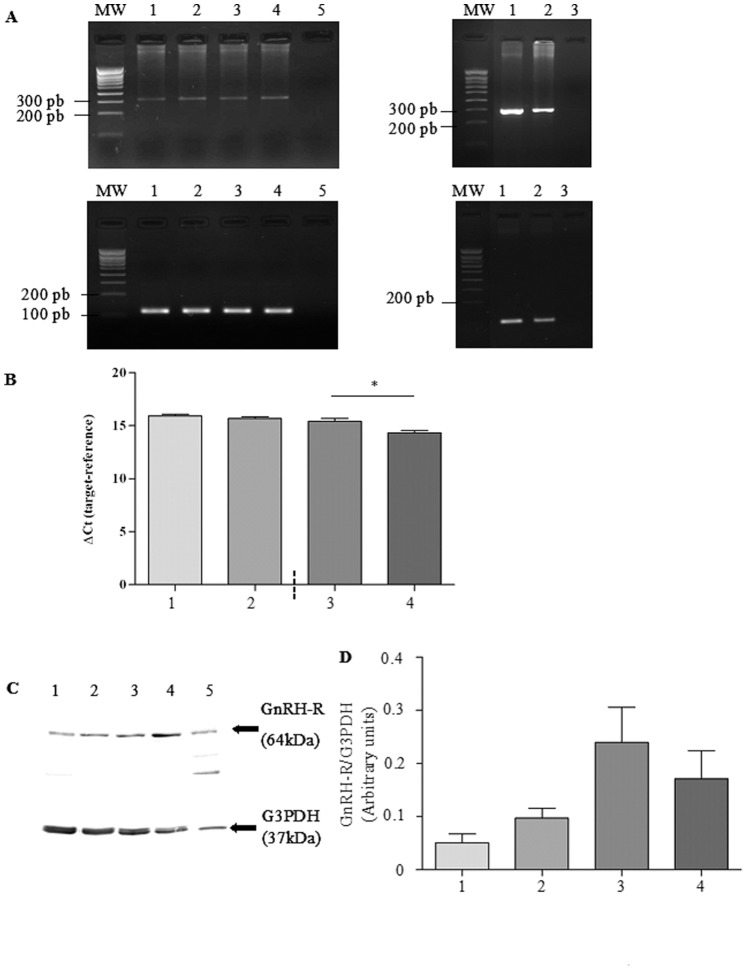
Basal mRNA and protein expression of GnRH-R.
A. The upper left panel shows representative PCR bands for GnRH-R (319 bp) after separation (2% agarose gel). A single band is observed in 16HBE14o− (lane 1), CFBE41o− (lane 2), CFBE41o−/corr (lane 3) and CFBE41o−/F508del (lane 4) cells. No signal is observed in the negative control (lane 5). The upper right panel shows positive controls (human pituitary gland and human MCF7cell line, lanes 1 and 2, respectively) for the detection of GnRH-R. cDNAs were from the human pituitary gland and the human MCF7cell line (breast adenocarcinoma), respectively. The mRNA expression of G3PDH (121 bp) is shown lower panel for the same samples. MW is the molecular weight given in base pairs (bp). B. The quantitative analysis (n = 5) of the mRNA of GnRH-R. Ct is the Cycle Threshold. A hight Ct correspond to low mRNA abundance because more PCR cycles are needed to detect it. Endogenous control has a lower Ct than the target mRNA. Therefore, a low ΔCt ( = Ct gene – Ct control) correspond to high mRNA abundance C. Upper panel shows representative immunoblots of GnRH-R (64 kDa) and lower panel shows representative immunoblots of G3PDH (37 kDa). A protein expression is observed in 16HBE14o− (lane 1), CFBE41o− (lane 2), CFBE41o−/corr (lane 3) and CFBE41o−/F508del (lane 4) cells. A positive control (lane 5) was used for the detection of GnRH-R (human breast duct carcinoma (T-47D) whole cell lysate). G3PDH was used for further normalization. D. The densitometric analysis of GnRH-R expression (n = 6) did not show any difference between cell lines.